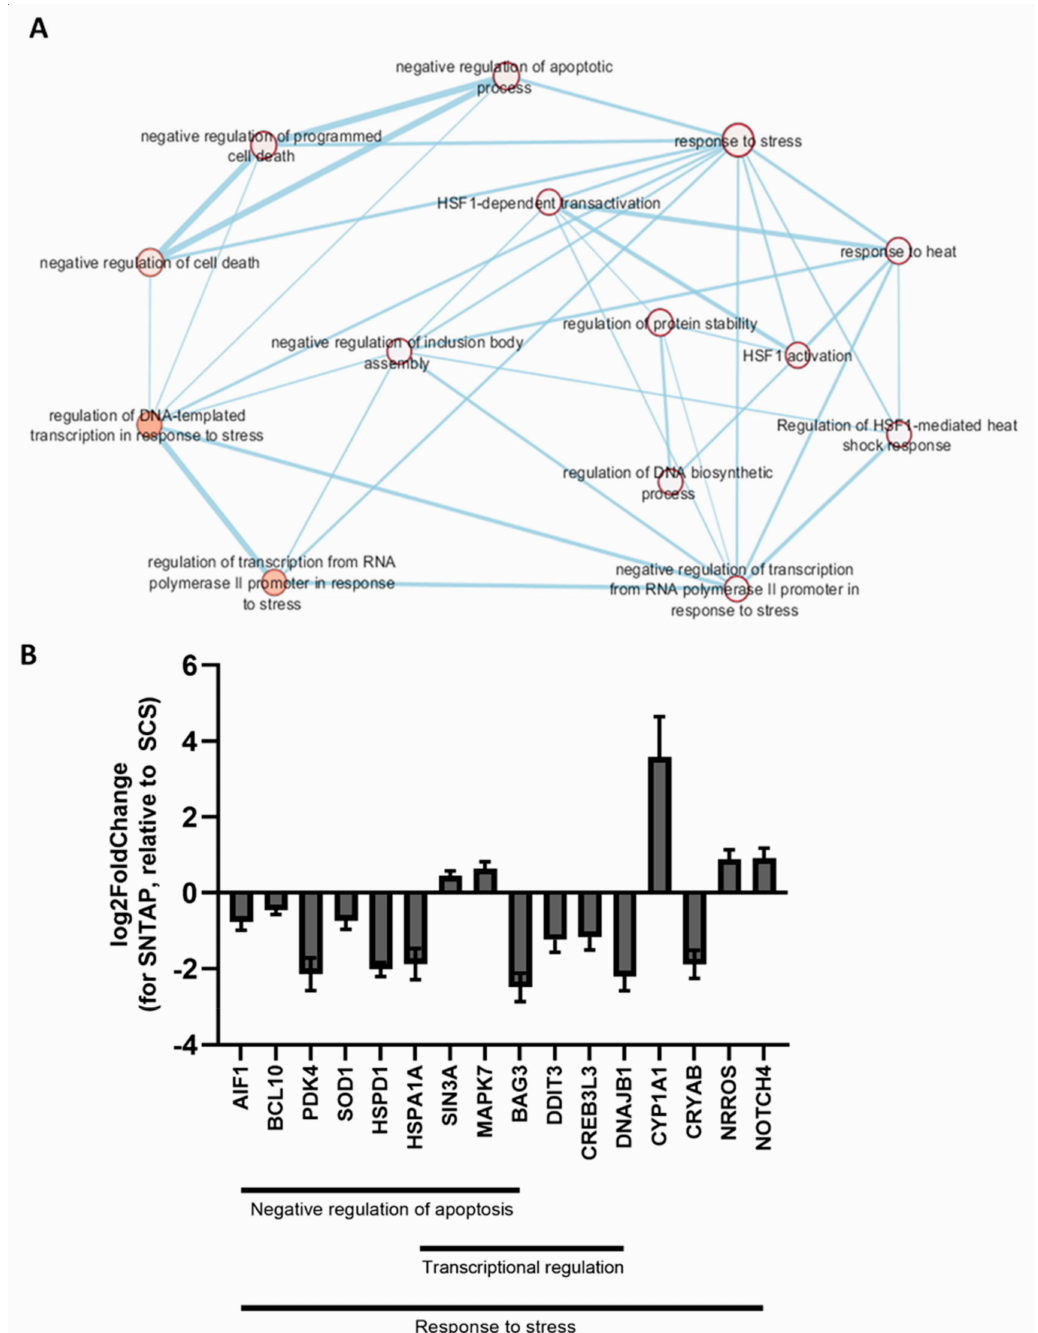
Figure 5. Gene expression analysis after preservation using subnormothermic perfusion with AP39 vs. static cold storage. Frozen renal cortical sections ( n = 3 for each group) were used for the RNAseq analysis. Differentially expressed genes were identified using RStudio (DESeq2; alpha = 0.05). Gene Ontology (GO) annotations were found for those genes using g:Profiler, and the network enrichment analysis was performed using Cytoscape. ( A ) Network enrichment map showing certain nodes of interest (FDR Q value < 1.0 and Jaccard Overlap combined coefficient > 0.375 with a combined constant = 0.5). ( B ) Gene expression values (log2 fold change ± SEM, determined using RStudio) of certain genes of interest chosen from three nodes of interest from the enrichment map in ( A )—response to stress, negative regulation of the apoptotic process and regulation of the DNA-templated transcription in response to